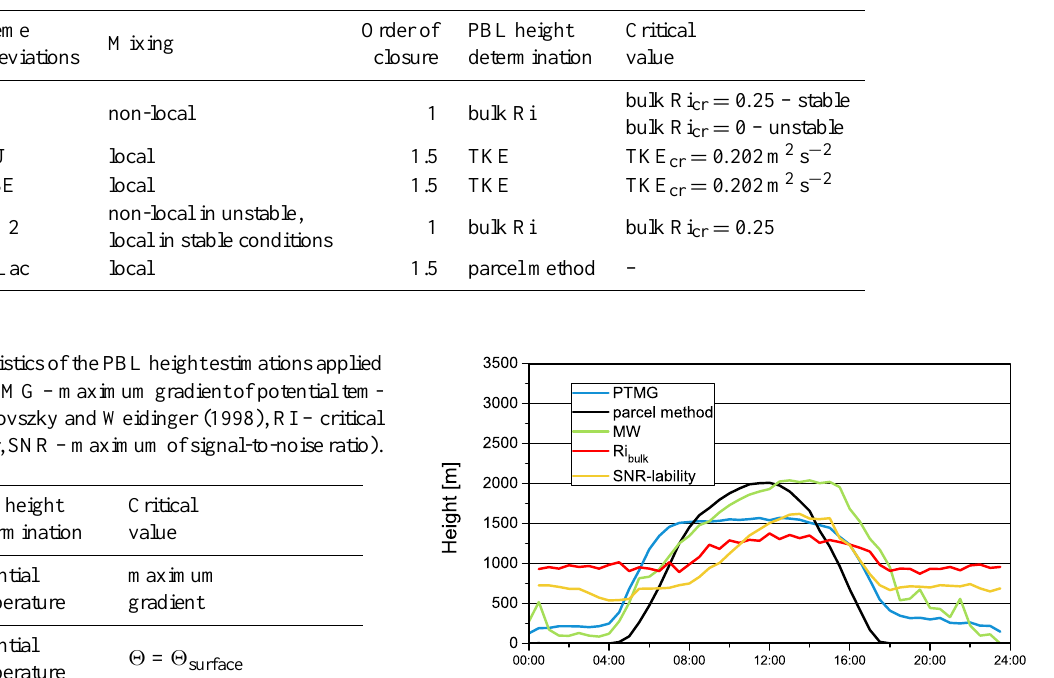
Table 1. Main physical features of the PBL parameterisations used in the WRF-SCM model (YSU – Yonsei University, MYJ – Mellor– Yamada–Janji´c, QNSE – quasi-normal scale elimination, ACM2 – Asymmetric Convective Model 2, BouLac – Bougeault–Lacarrère).